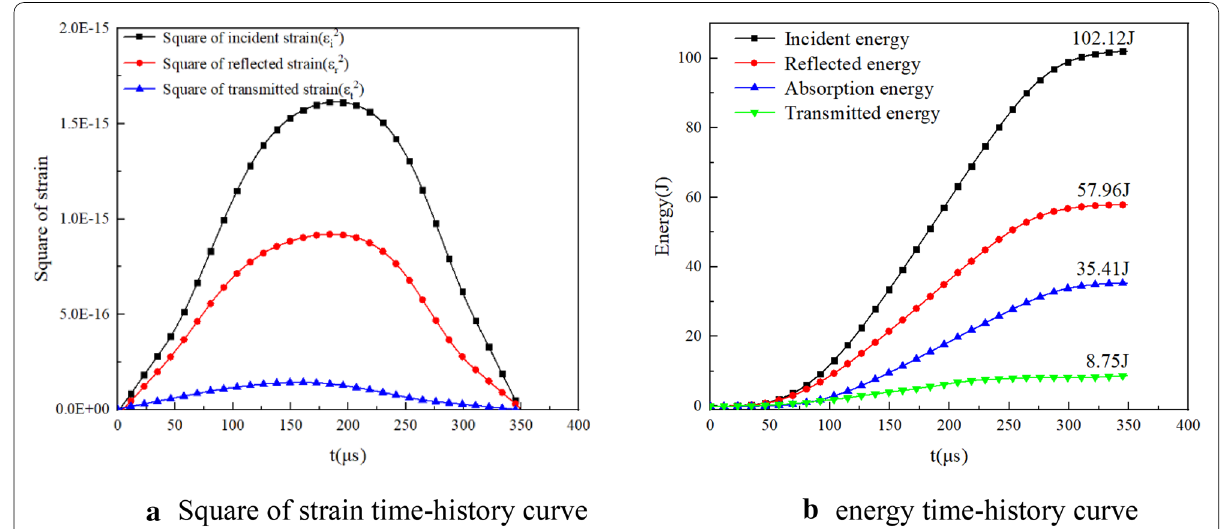
Fig. 15 Time-history